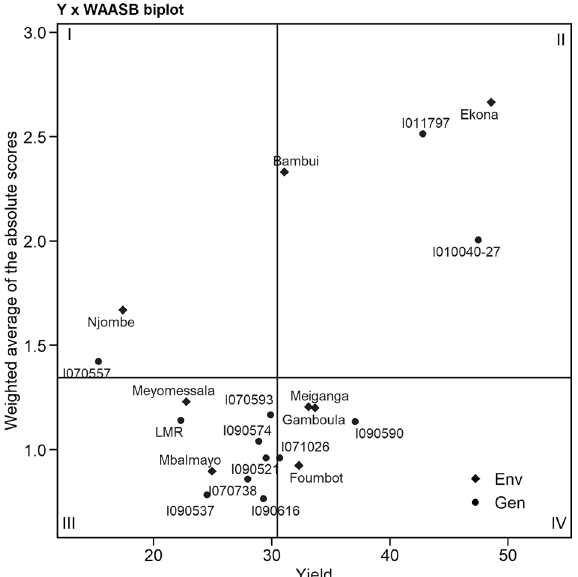
Figure 4. Biplot of the fresh root yield versus a weighted average of absolute scores for the best linear unbiased prediction s of the genotype versus environment interaction (WAASB) of 12 genotypes evaluated in eight environments. A hypothetical highly productive and broadly adapted genotype is depicted by a black circle. (R V3.6.2, https:// cran.r- proje ct. org/ web/ packa ges/ metan/).